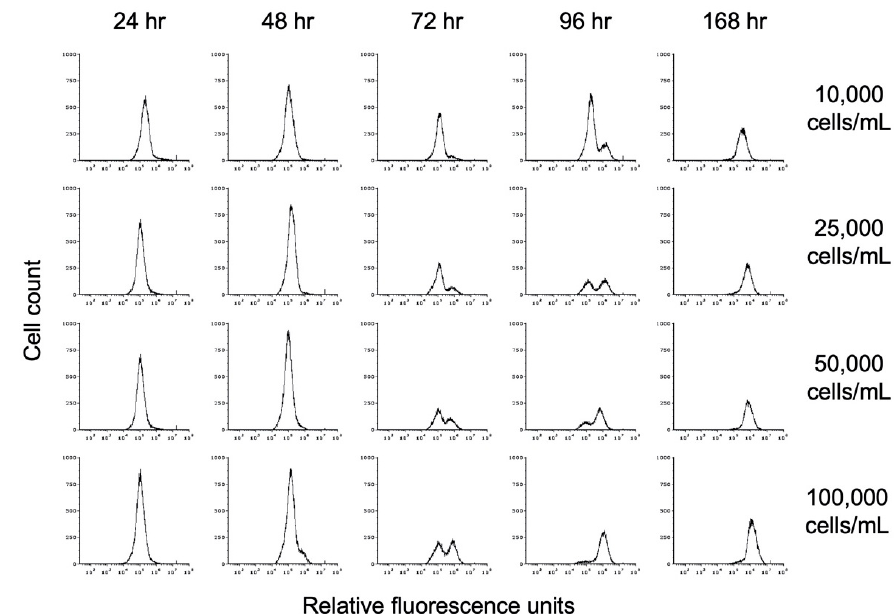
Figure 5. Flow cytometry analysis of the effect of starting cell density on encystation. Replicate E. histolytica cultures inoculated at 10,000, 25,000, 50,000, or 100,000 trophozoites/mL into TYI basal medium were harvested at 24, 48, 72, 96, and 168 h, stained with WGA-488, and analyzed by flow cytometry. Histograms display cell count versus relative fluorescence units and are uniform for direct comparison of the position and size of the peaks. Three biological replicates were performed, and the results shown are representative.